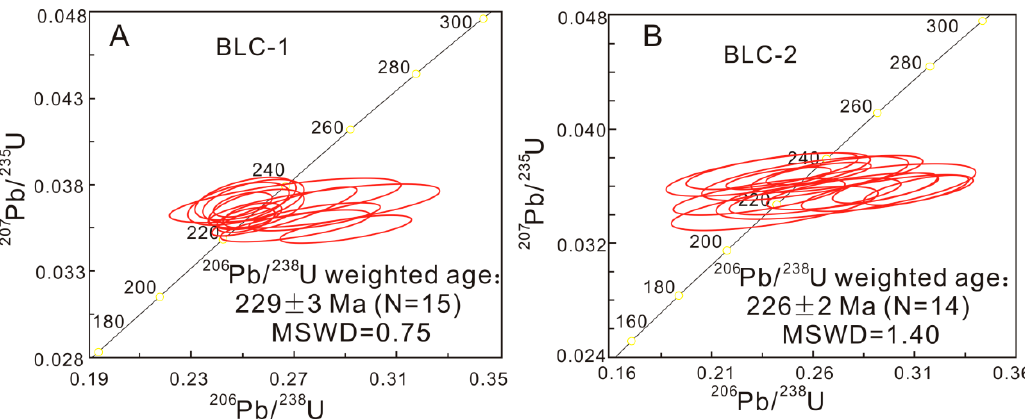
Figure 6. Zircon LA-ICP-MS U–Pb concordia diagrams for ( A ) BLC-1 and ( B ) BLC-2. The weighted mean age and MSWD are shown in each figure.